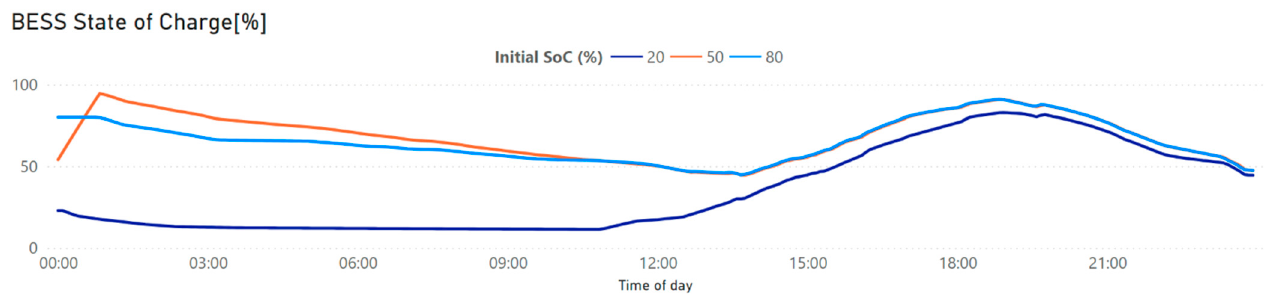
Figure 15. SOC variation by time of day for each BESS initial SOC.